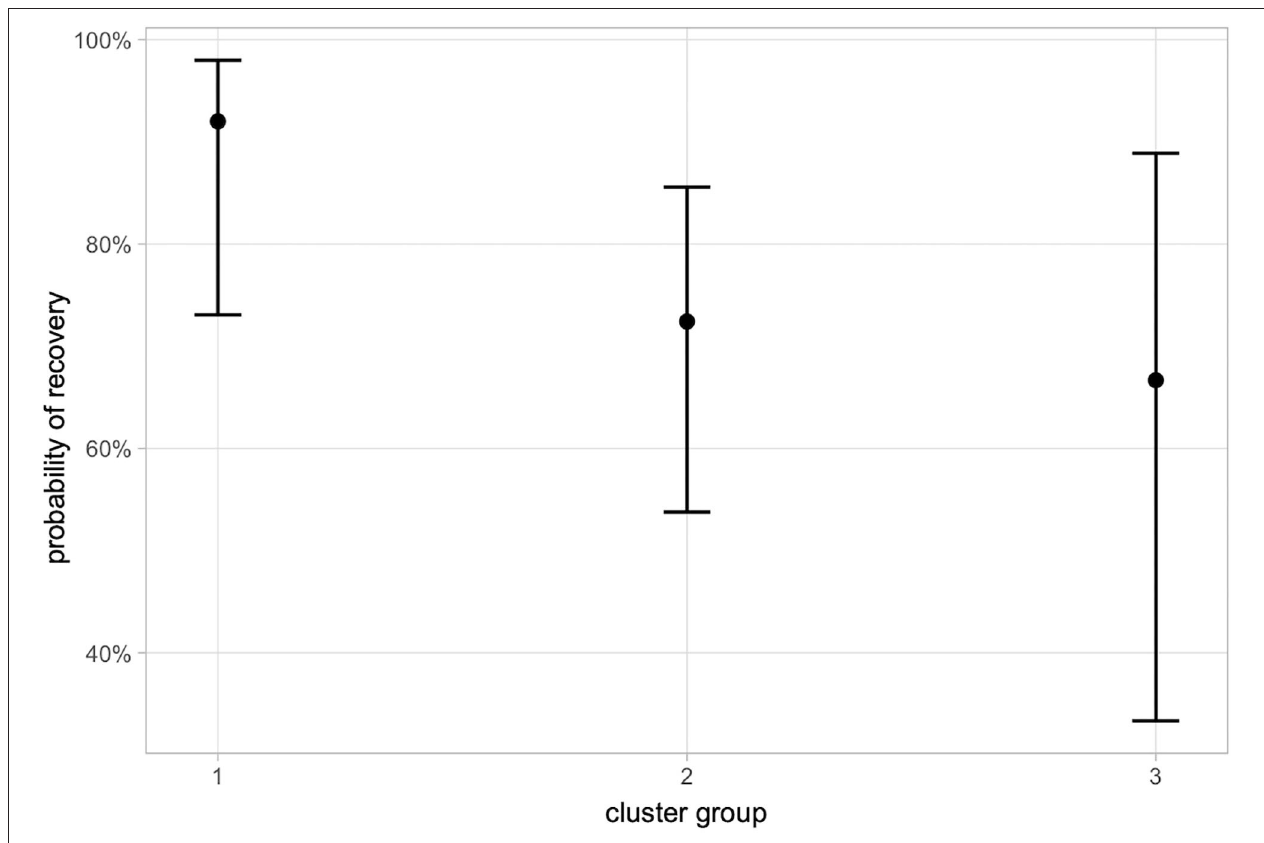
FIGURE 4 | Probability of recovery in different cluster groups. 1, Purely inflammatory IMPN; 2, IMPN accompanied by de-/remyelination; 3, IMPN accompanied by Wallerian